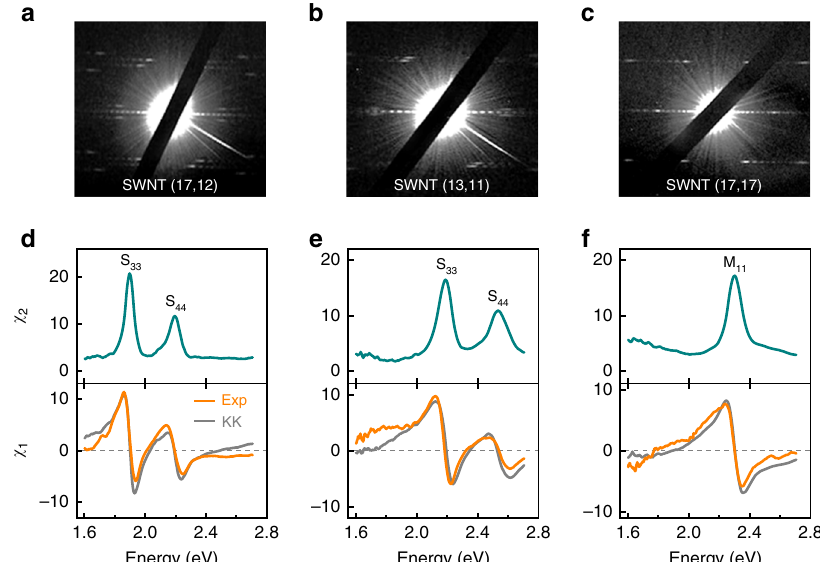
Fig. 3 Systematical complex optical susceptibility measurement of individual nanotubes. a – c Electron diffraction patterns of three single-walled carbon nanotubes with different chiral indices. The (17, 12) semiconducting nanotube ( a ) has a diameter of 1.98 nm; the (13,11) semiconducting nanotube ( b ) has a diameter of 1.63 nm; the (17,17) metallic nanotube ( c ) has a diameter of 2.31 nm. d – f , Measured imaginary ( χ 2 , green) and real ( χ 1 , orange) susceptibility of nanotubes in a – c under θ = 2°. Optical transitions types are marked above each peak. The calculated real susceptibility ( χ KK transformation of χ 2 in a fi nite photon energy range (1.6 – 2.7 eV) were also shown. A good agreement between χ 1 and χ KK peak region, while obvious deviation can happen in non-resonant region. Optical transitions are marked above each